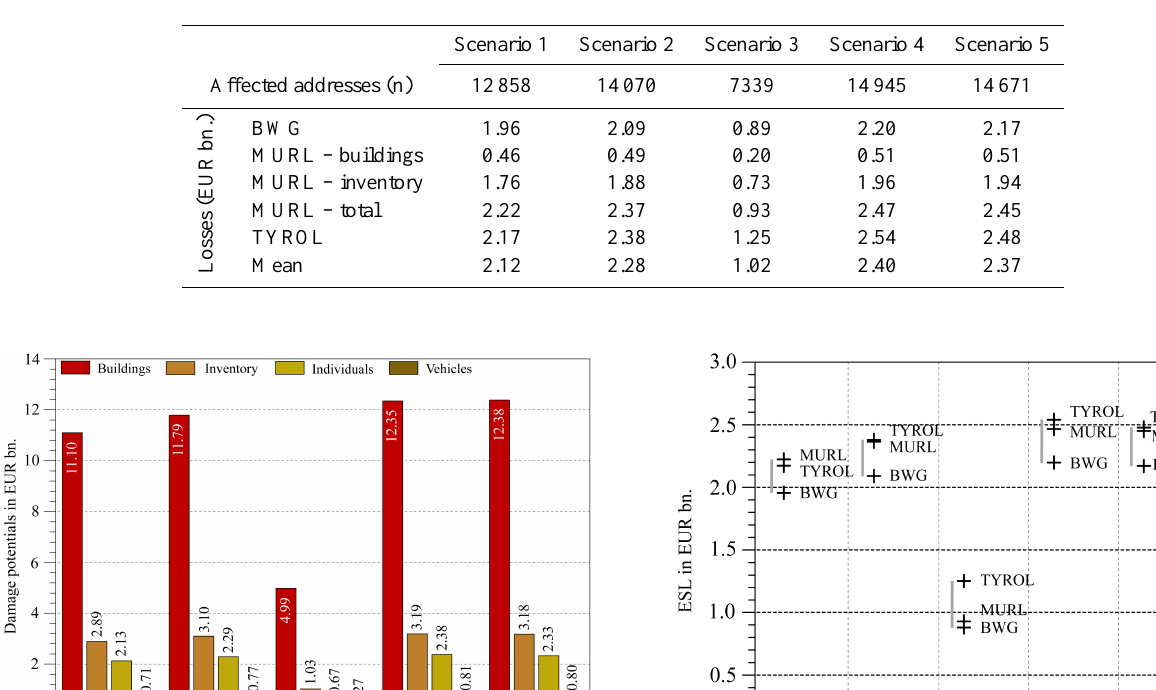
Table 4. Number of affected addresses and ESL under consideration of the different applied approaches and scenarios. The mean ESL based on the applied approaches is additionally listed.